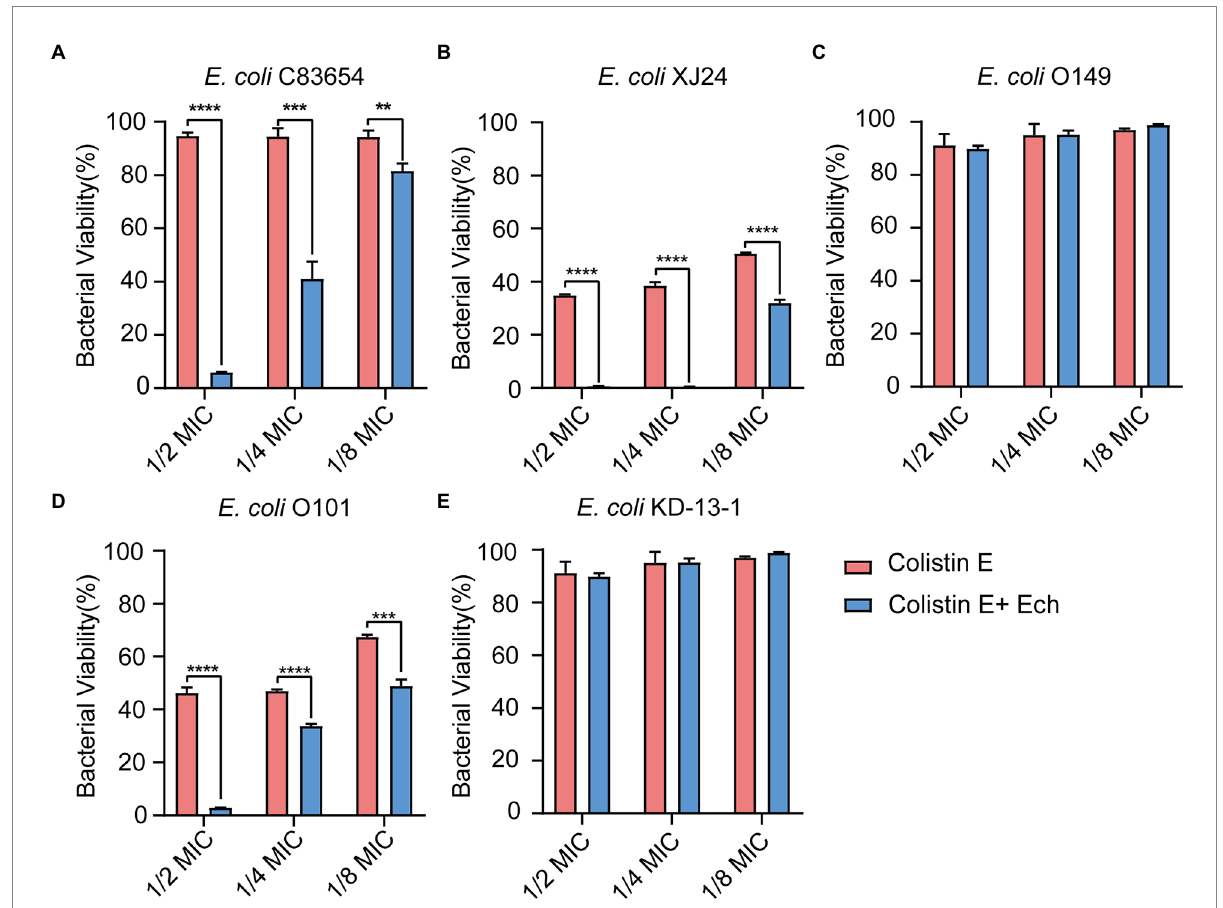
FIGURE 10 Synergistic effects of Ech (50 μ M) with Colistin E in five different E. coli on bacterial viability. E. coli (A) C83654, (B) XJ24, (C) O149, (D) O101, (E) KD-13-1. Data represent means ± SD of three experiments conducted in triplicate. ** = p < 0.01; *** = p < 0.001; **** = p < 0.0001.